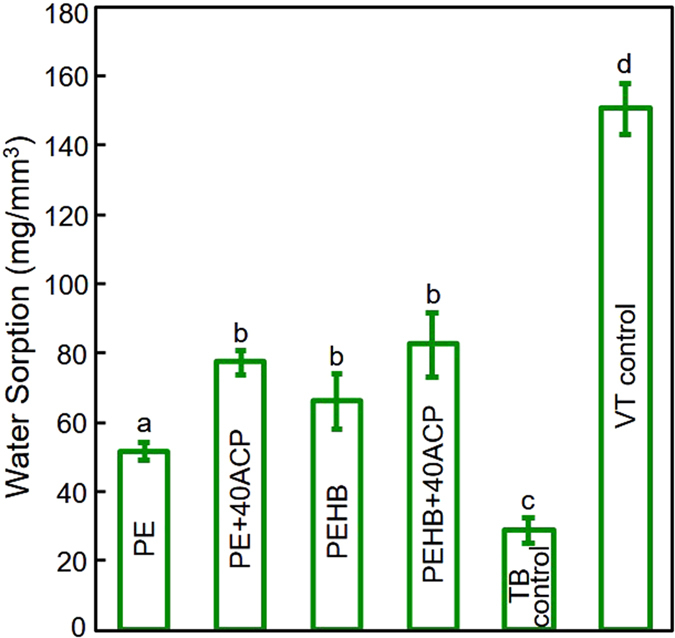
Results for water sorption (mean ± sd; n = 3).Bars with dissimilar letters indicate values that are significantly different from each other (p < 0.05).